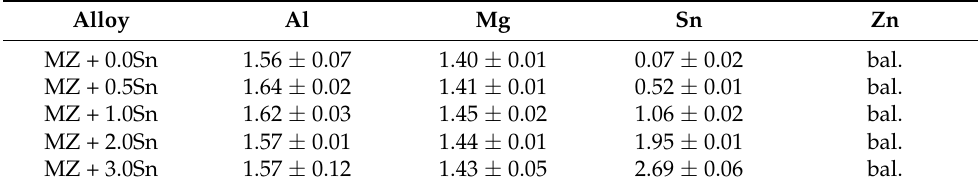
Table 1. Chemical composition of the studied alloys